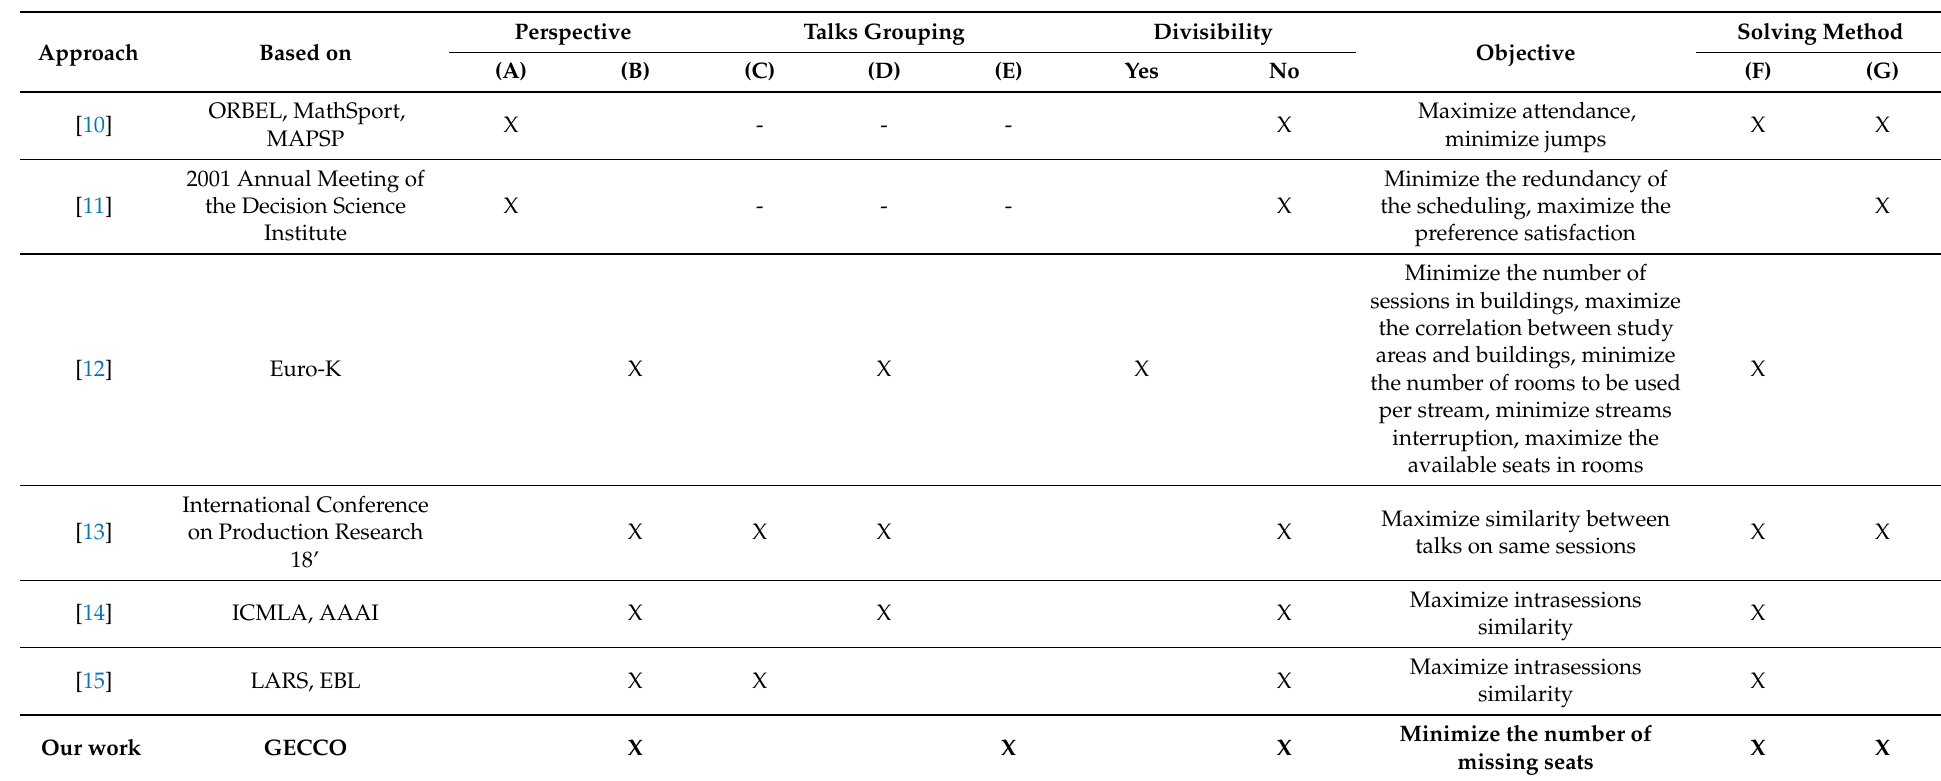
Table 1. Classification of the reviewed works. In the table header: Perspective—(A): Attender-based or (B): Presenter-based; Talks grouping—(C): Topic-based, (D): Keyword-based or (E): Track-based; Solving method—(F): Exact Search or (G): Local